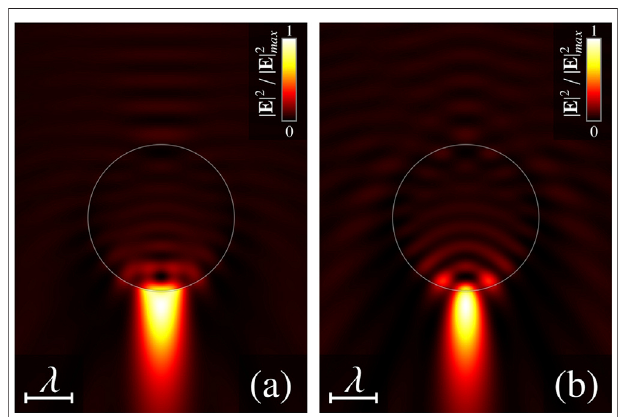
FIGURE 1 | Near- fi eld intensity distributions in (A) the x - z plane and (B) the y - z plane. Incident wave is the non-vortex Gaussian beam ( LG 0,0 ). Parameters are: f (cid:2) 0.02, R p (cid:2) 1.5 λ , n r (cid:2)